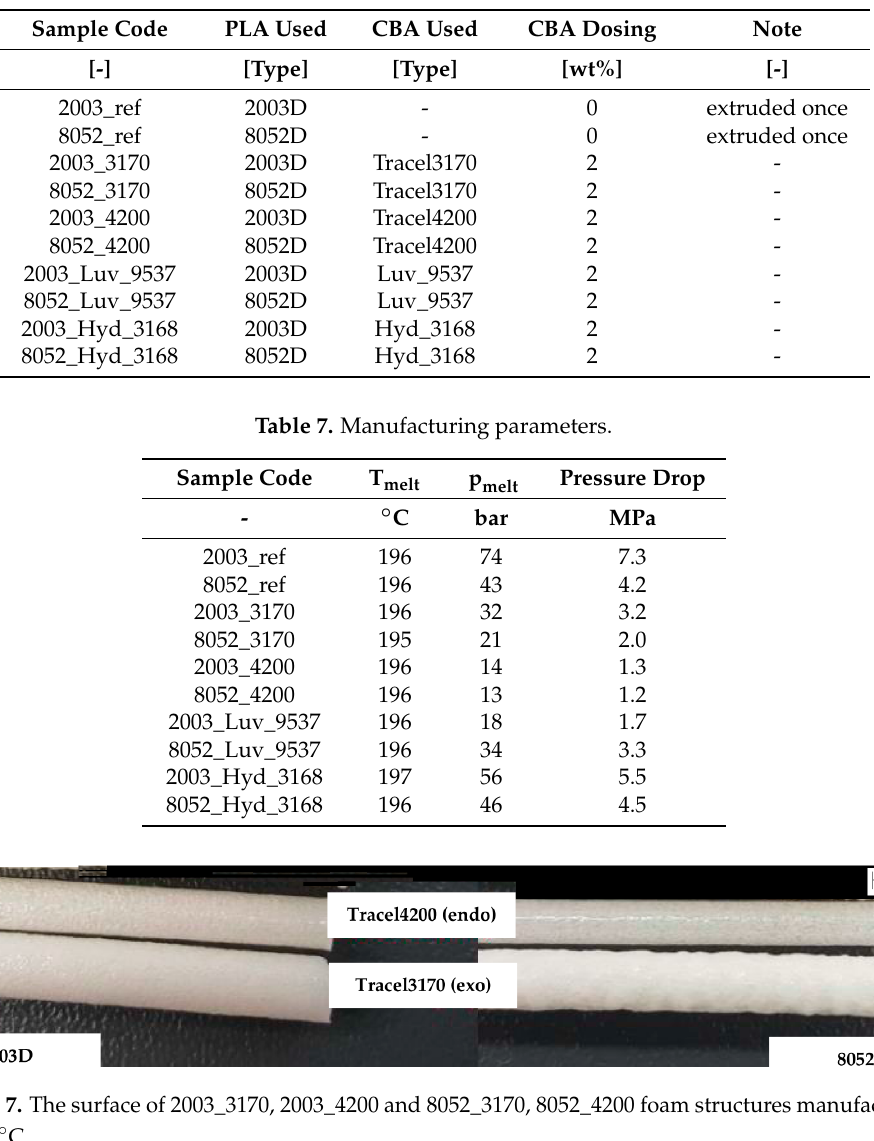
Table 6. The designation of the samples and their recipes.